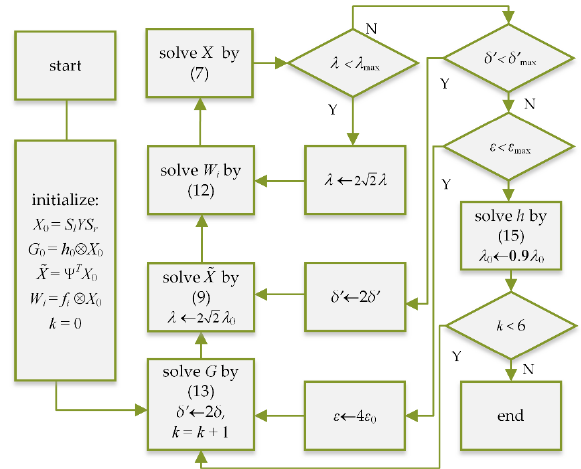
Figure 2. The flow of the blur kernel estimation algorithm.